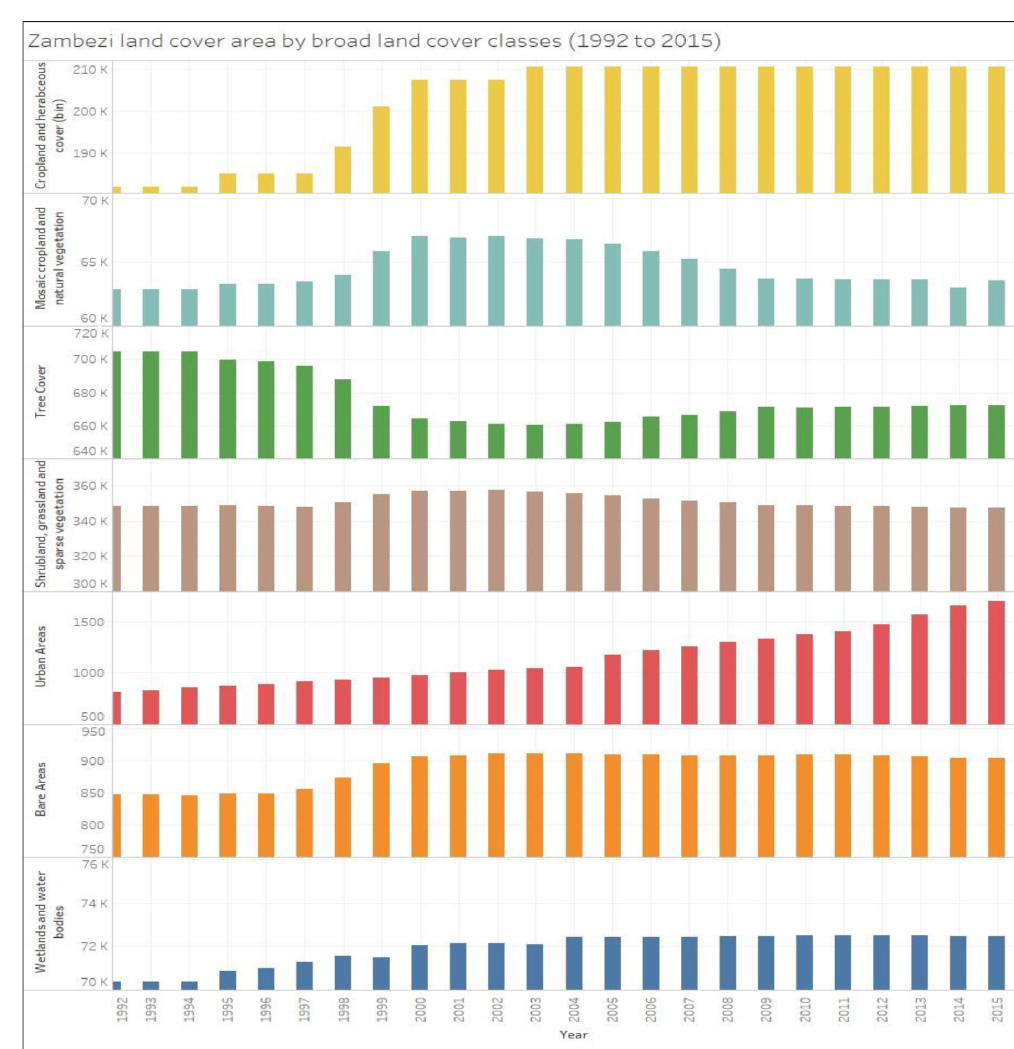
Figure 5. Changes in land cover area (in square kilometres) in the Zambezi river